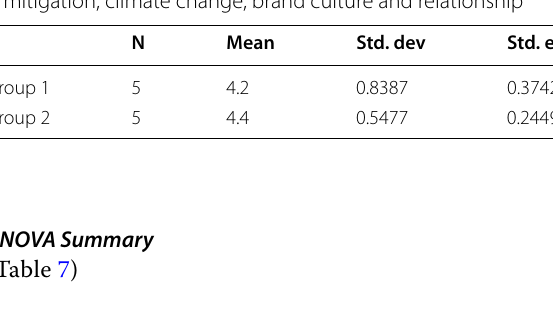
Table 7 ‘ANOVA statistics and summary on perception of risks & mitigation, climate change, brand culture and relationship